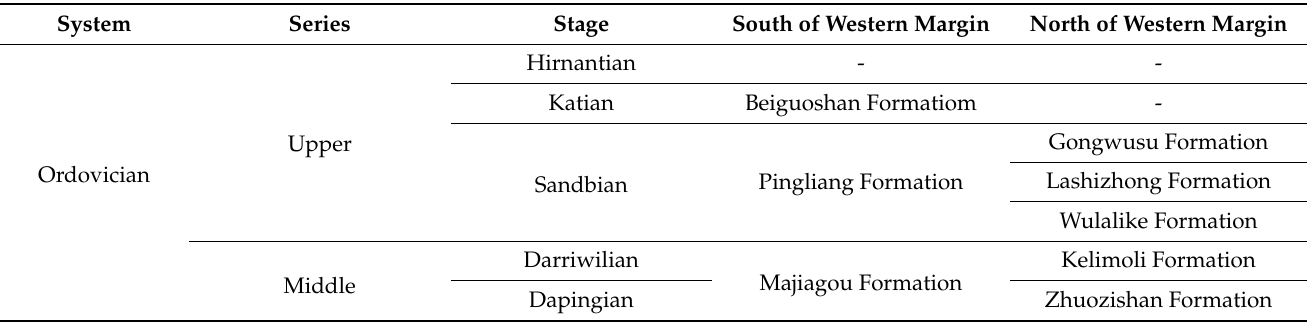
Table 1. Stratigraphic correlation between the south and north of western Margins of Middle and Upper Ordovician in the Ordos Basin